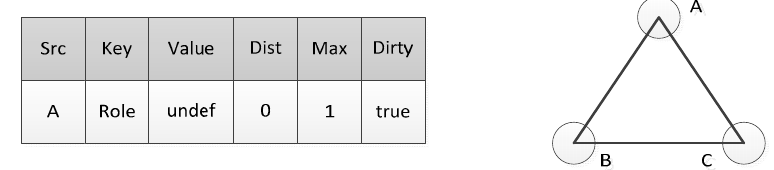
Figure 12. The role table and the relative topology of A, B, C.